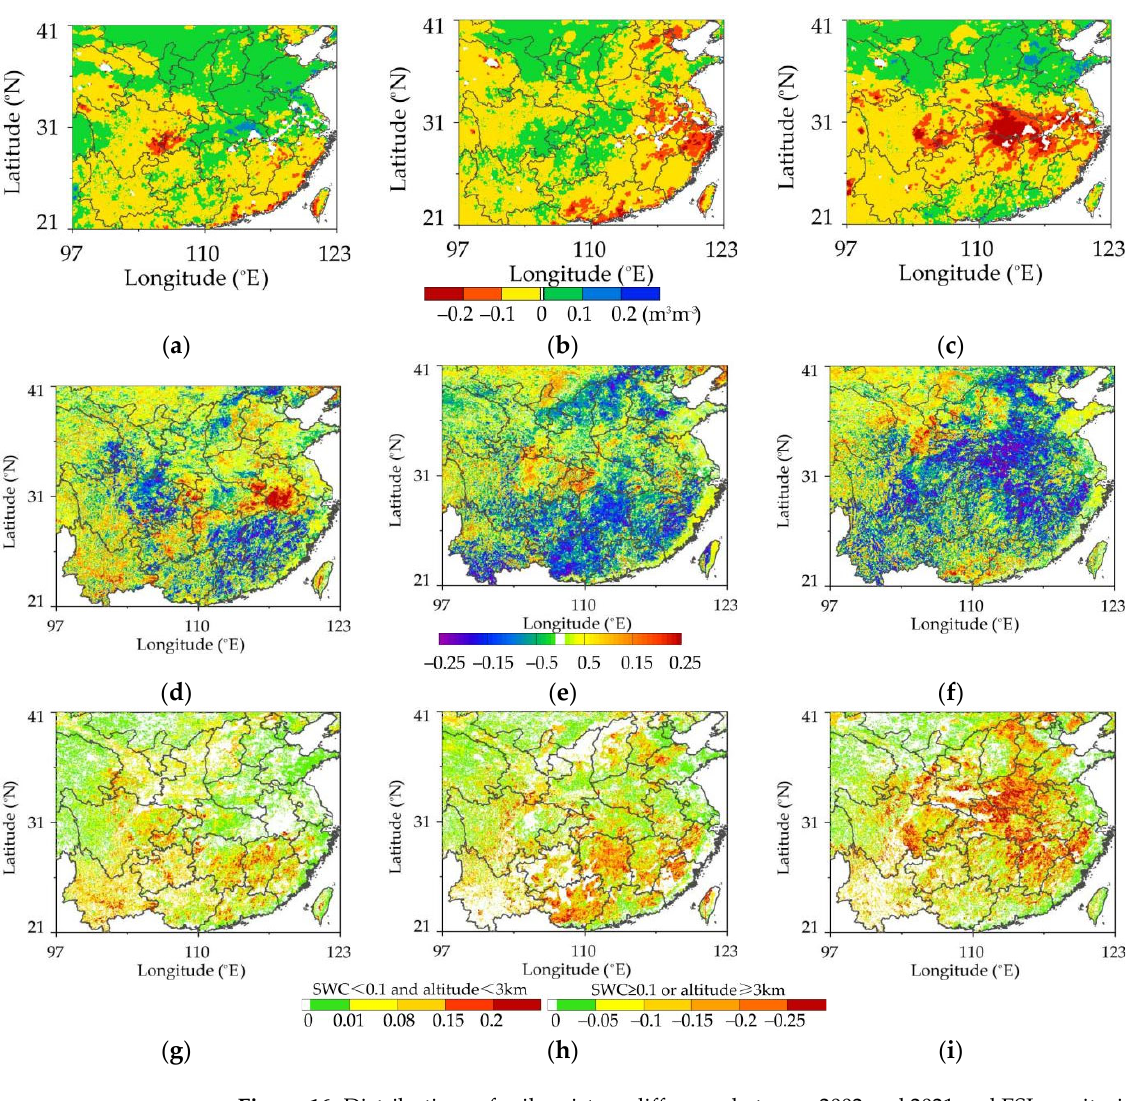
Figure 16. Distributions of soil moisture difference between 2002 and 2021 and ESI monitoring results, where ( a – c ) are the distributions of soil moisture difference in late June, late July, and middle August, respectively; and ( d – f ) are the normal ESI monitoring results in late June, late July, and middle August, respectively; and ( g – i ) are the monitoring results of ESI after zoning based on soil moisture.